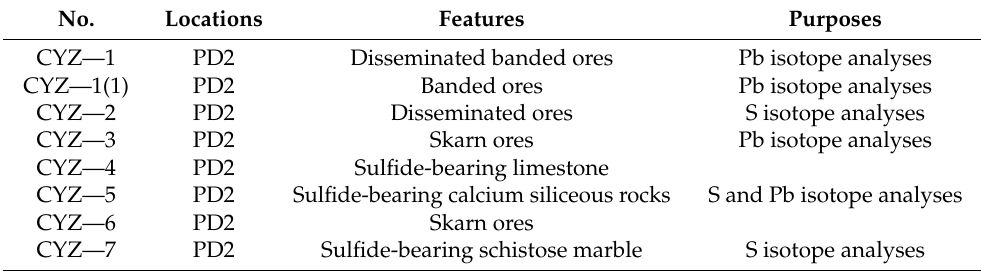
Table 1. Information of the